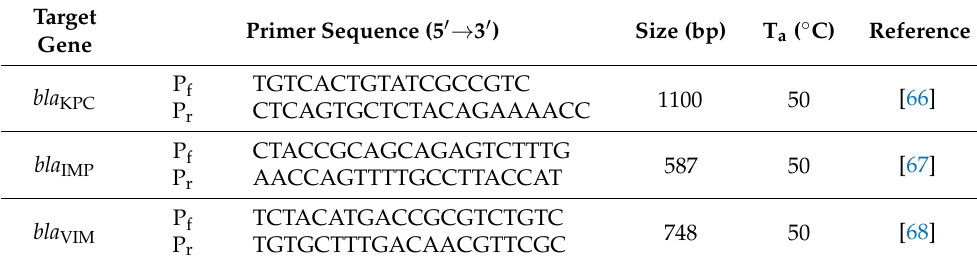
Table 5. Primers used in this study, the target resistance genes, the expected product sizes (bp), the used annealing temperatures (T a ) and their